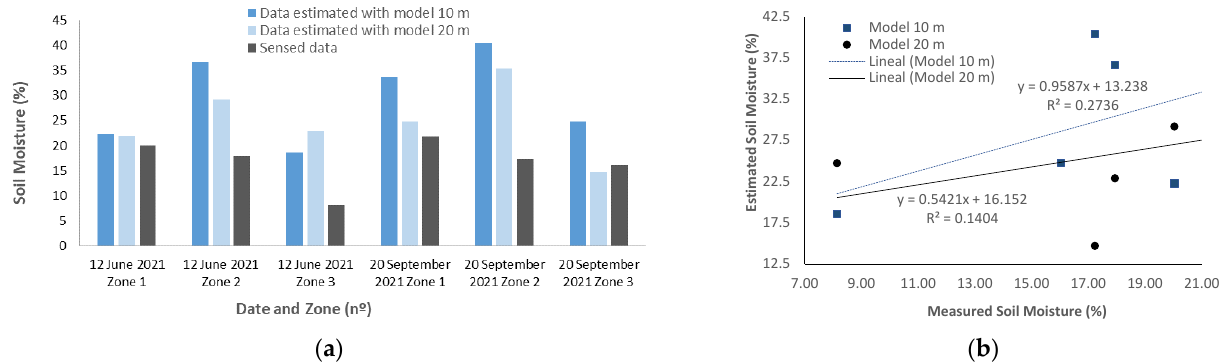
Figure 10. Results of quantitative verification in terms of ( a ) graphic bars of estimated and sensed data and ( b ) bivariate correlations.